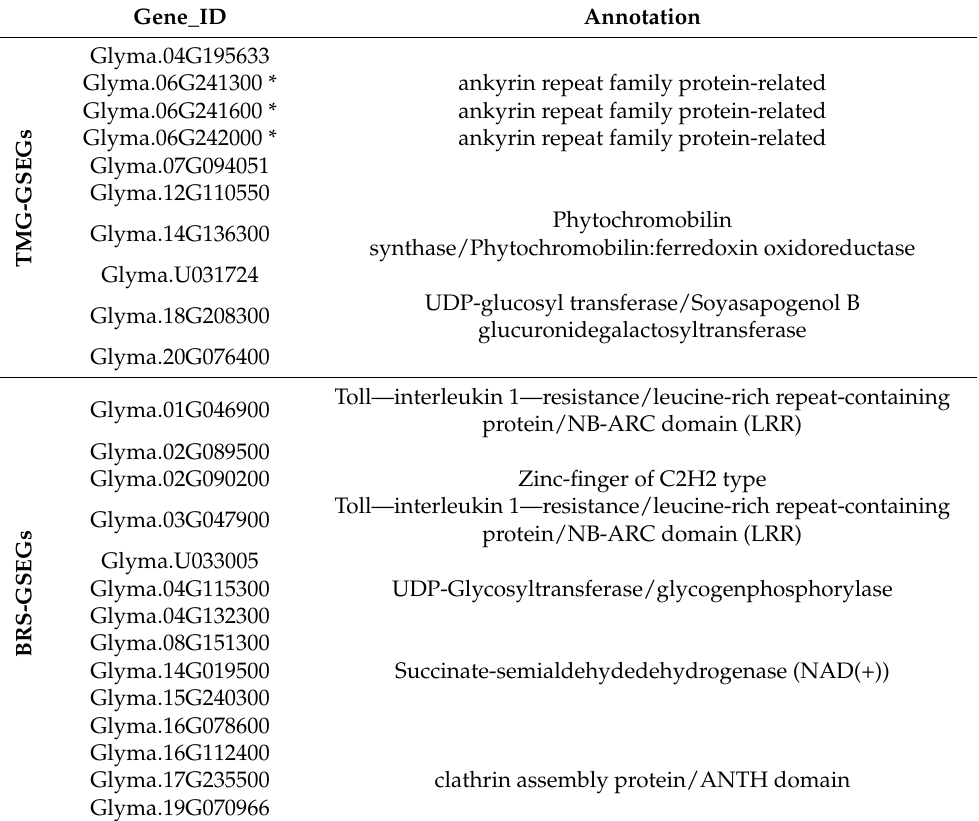
Table 1. Genotype-specific expressed genes (GSEGs) identified in BRS and TMG and respective functional